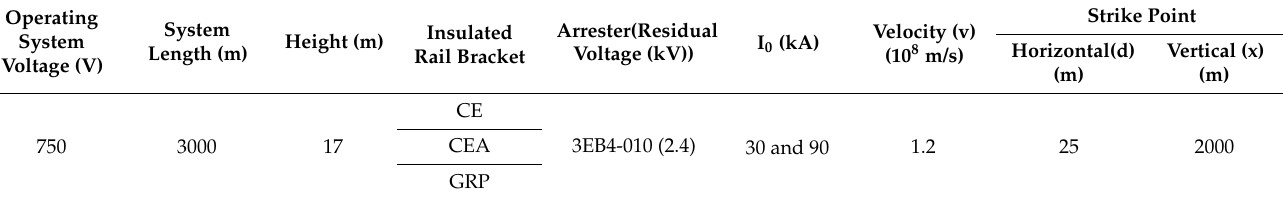
Table 2. The relative simulation